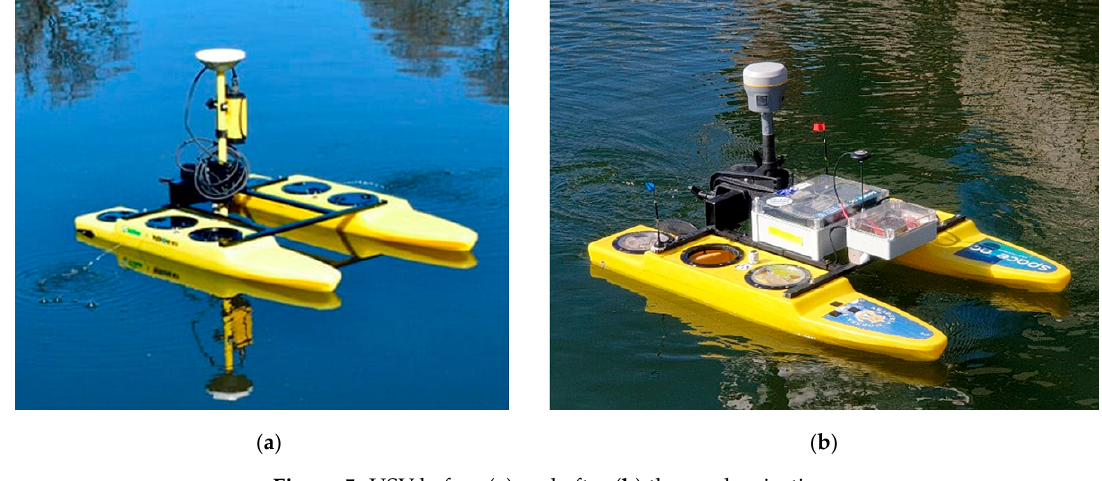
Figure 5. USV before ( a ) and after ( b ) the modernisation.